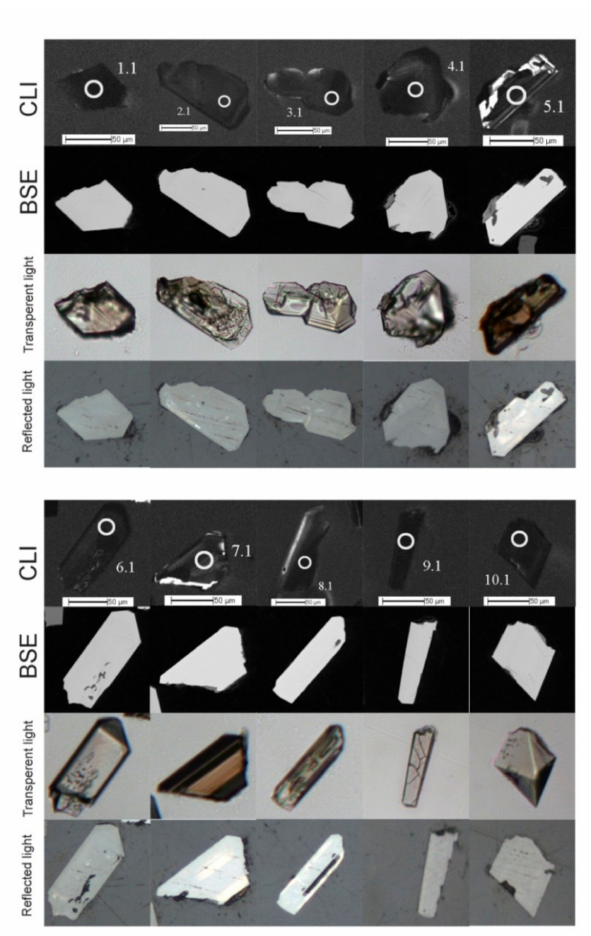
Figure 15. Zircon (1–4 and 9–10) and baddeleyite (5–8) grains from the gabbro-dolerite of the Daldykan intrusion (sample Dl-1).